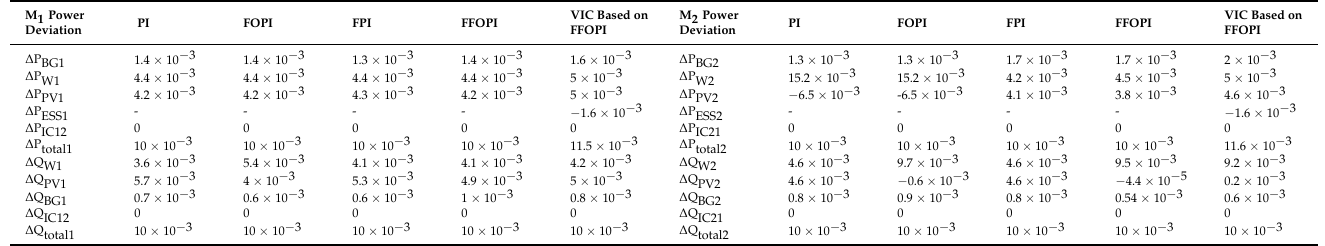
Table 15. Power flow in pu of microgrid system M 2 and M 2 for each controller at disconnecting tie line.